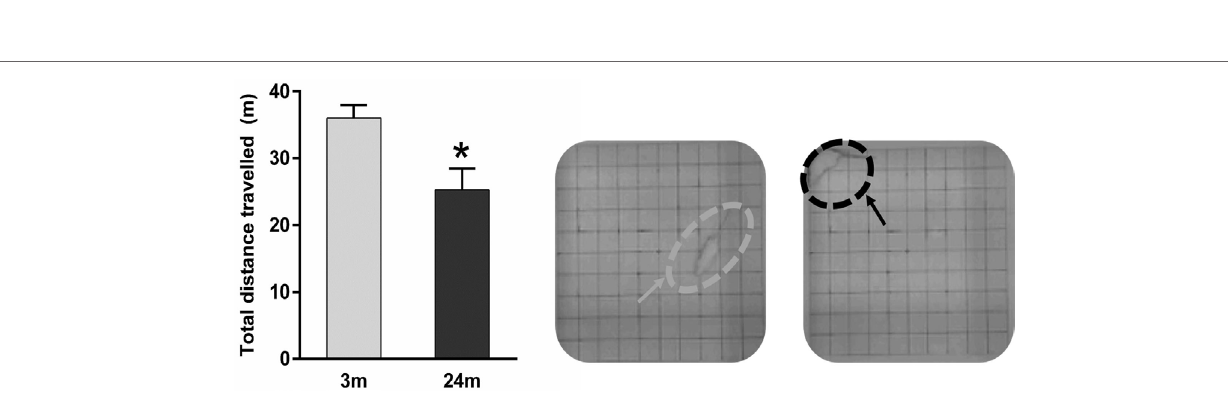
FigUre 2 | significantly lower pixel density measurements (pixels/21 cm 2 ) of 3-month-old rats’ snout muscle fibers compared with 24-month-old rats (Mann–Whitney U test, p < 0.05) . Representative 20 × H&E images of 3-month (gray label, n = 5) and 24-month (black label, n = 4)